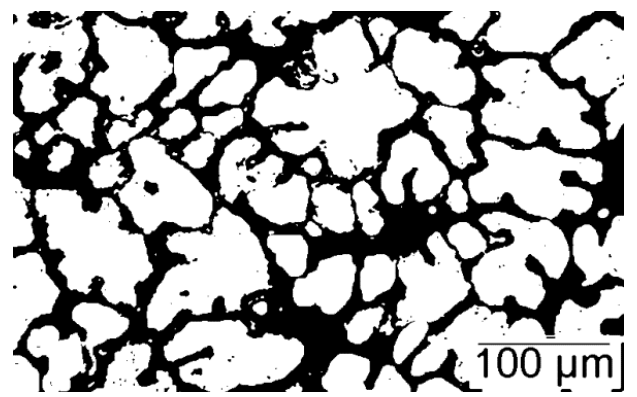
Figure 4. Binarized micrograph of Sample 1.